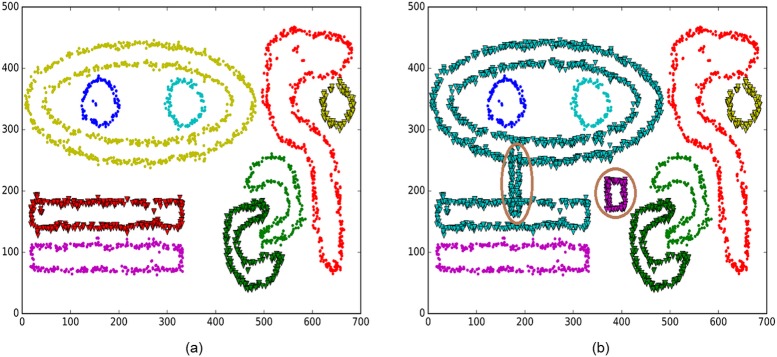
An incremental clustering results of the BPIC method.(a) The boundary profiles of the old clusters. (b) The final updated clustering results obtained by the BPIC method with 600 appended data points.